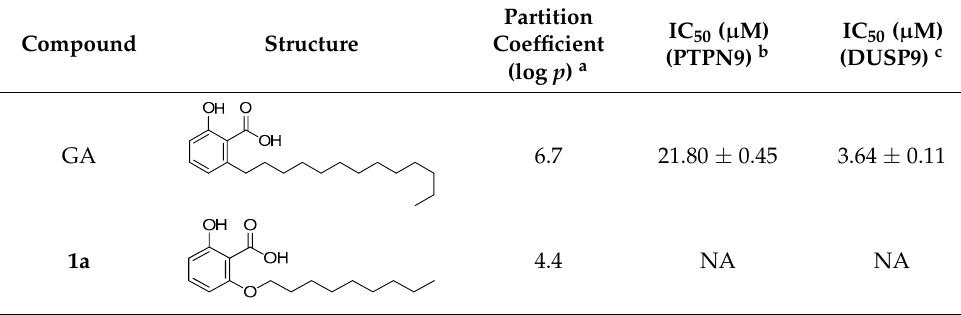
Table 1. The activity of the GA analogs.